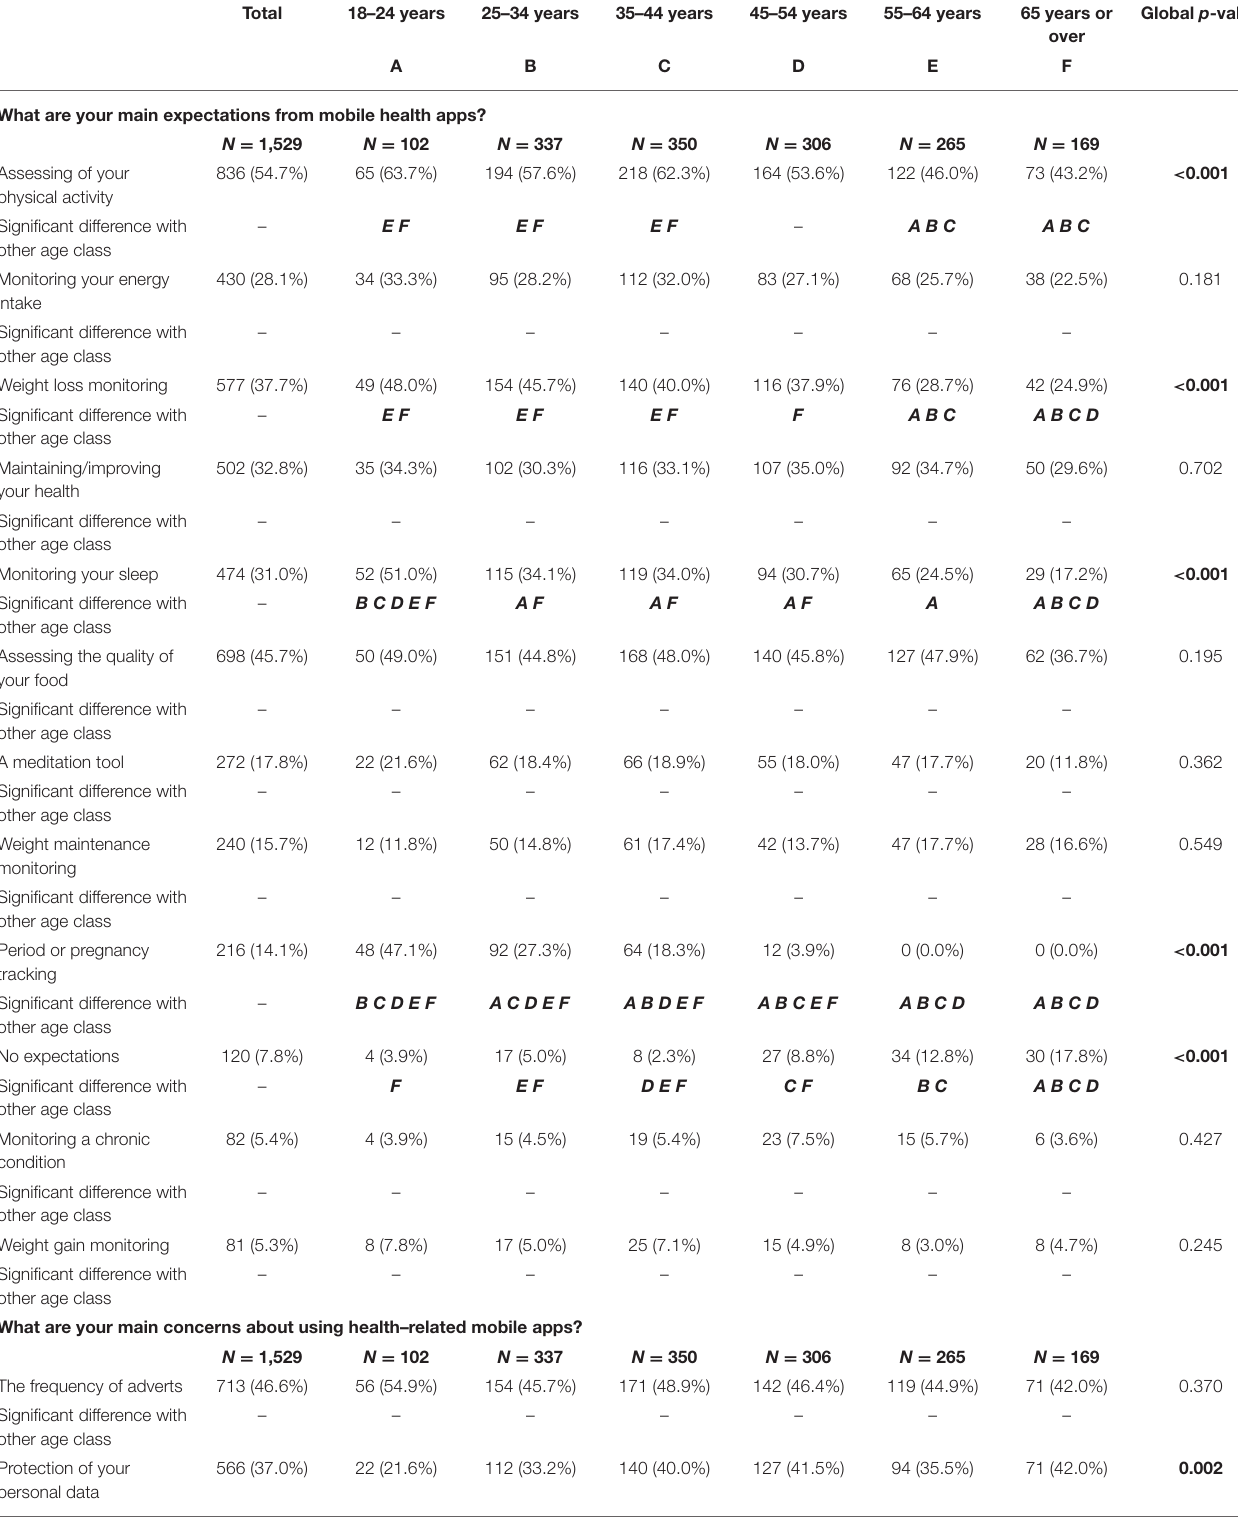
TABLE 3 | Smartphone apps expectations and concerns by age